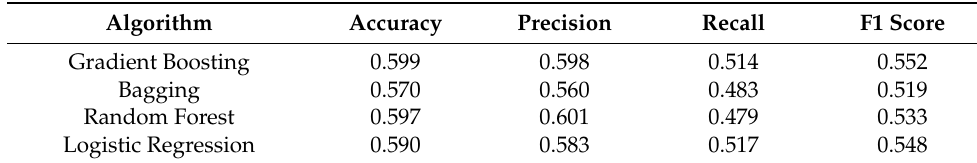
Table 1. Summary of the performance of the algorithms for the classification of the citation rate in the analyzed corpus. Algorithm